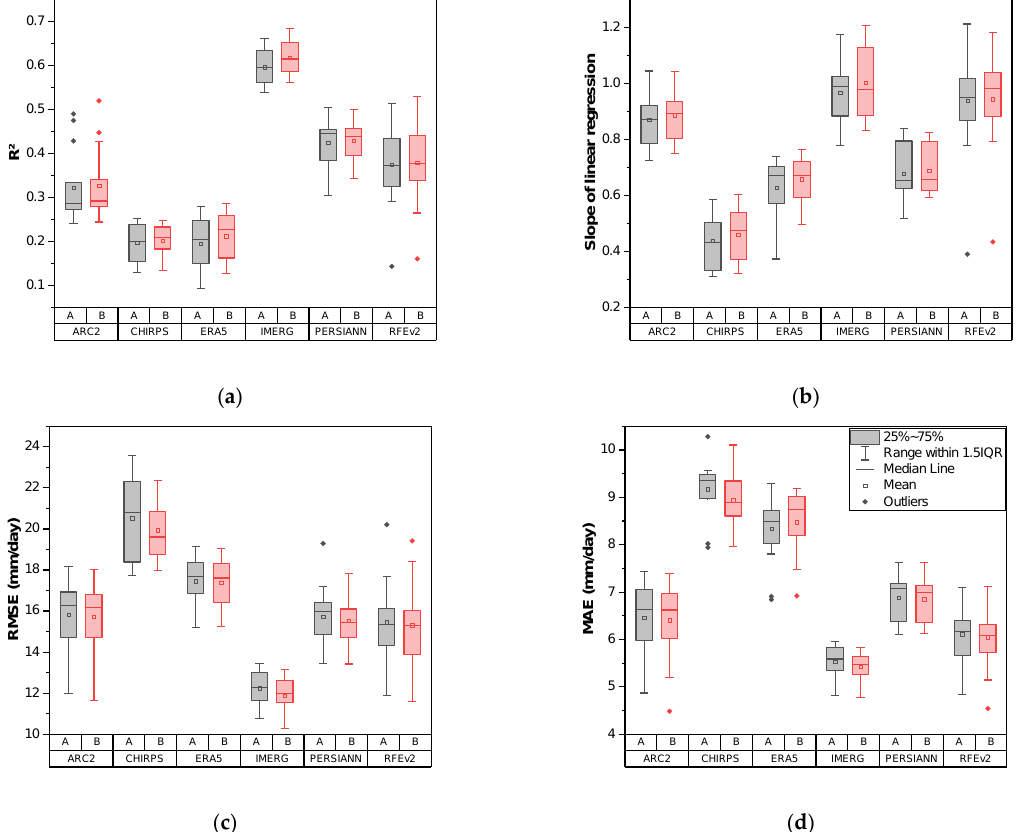
Figure 3. Comparison of ground-based precipitation data with 6 GPPs at a daily time scale from September 2018 to August 2020 based on 4 indicators: ( a ) Coefficient of determination, ( b ) Slope of linear regression, ( c ) Root Mean Square Error, ( d ) Mean Absolute Error. Each box plot is based on 2 years of data from 14 rain gauges in the Ankavia watershed. ‘A’ refers to the point-to-grid approach (grey boxes and whiskers) and ‘B’ to the point-gridded approach (red boxes and whiskers) (see Figure 2). Box edges correspond to the 25th (Q1) and 75th (Q3) percentiles. Whiskers extend to Q1-1.5IQR (lower bound) and Q3+1.5IQR (upper bound), with IQR = Q3–Q1 (Inter-Quartile Range). Points outside the box are